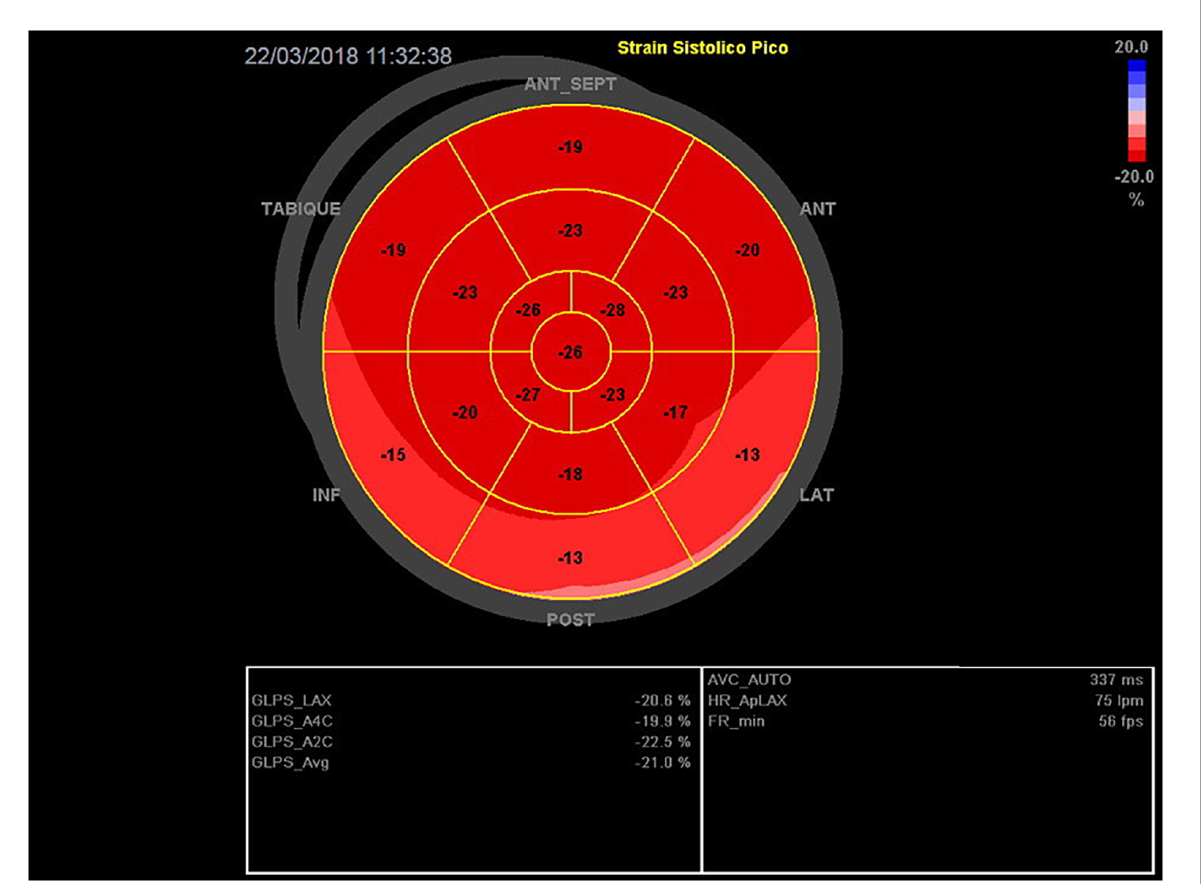
FIGURE5 Global longitudinal strain (Bull’s eye plot) at day 22. There is a remarkable, and practically complete, recovery from the severe initial compromise of the segmentary wall motion abnormalities observed on day 0. Global systolic function is preserved (GLS −